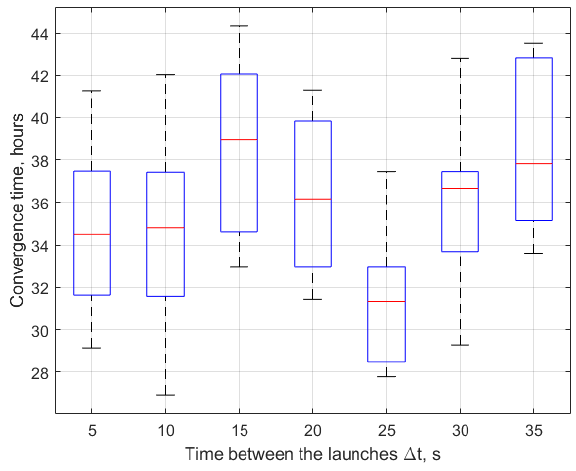
Figure 10. The dependence of the time of tetrahedron construction on the time between launches.